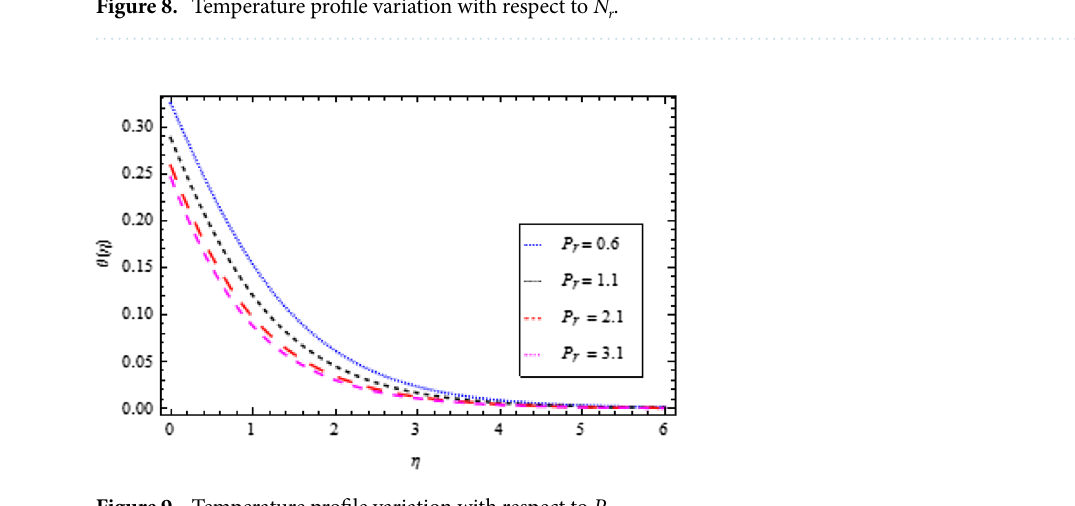
Figure 9. Temperature profile variation with respect to P r